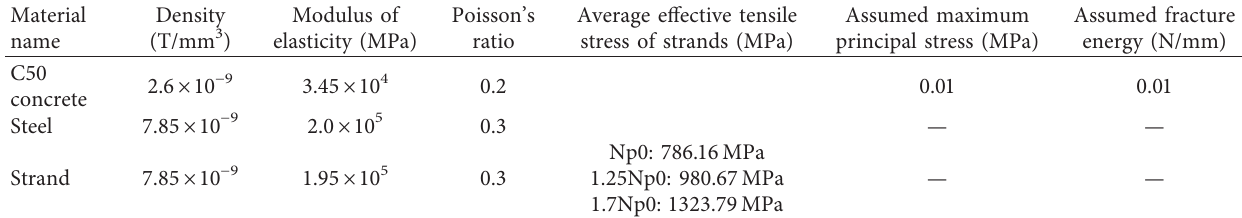
Table 3: Material calculation parameters.